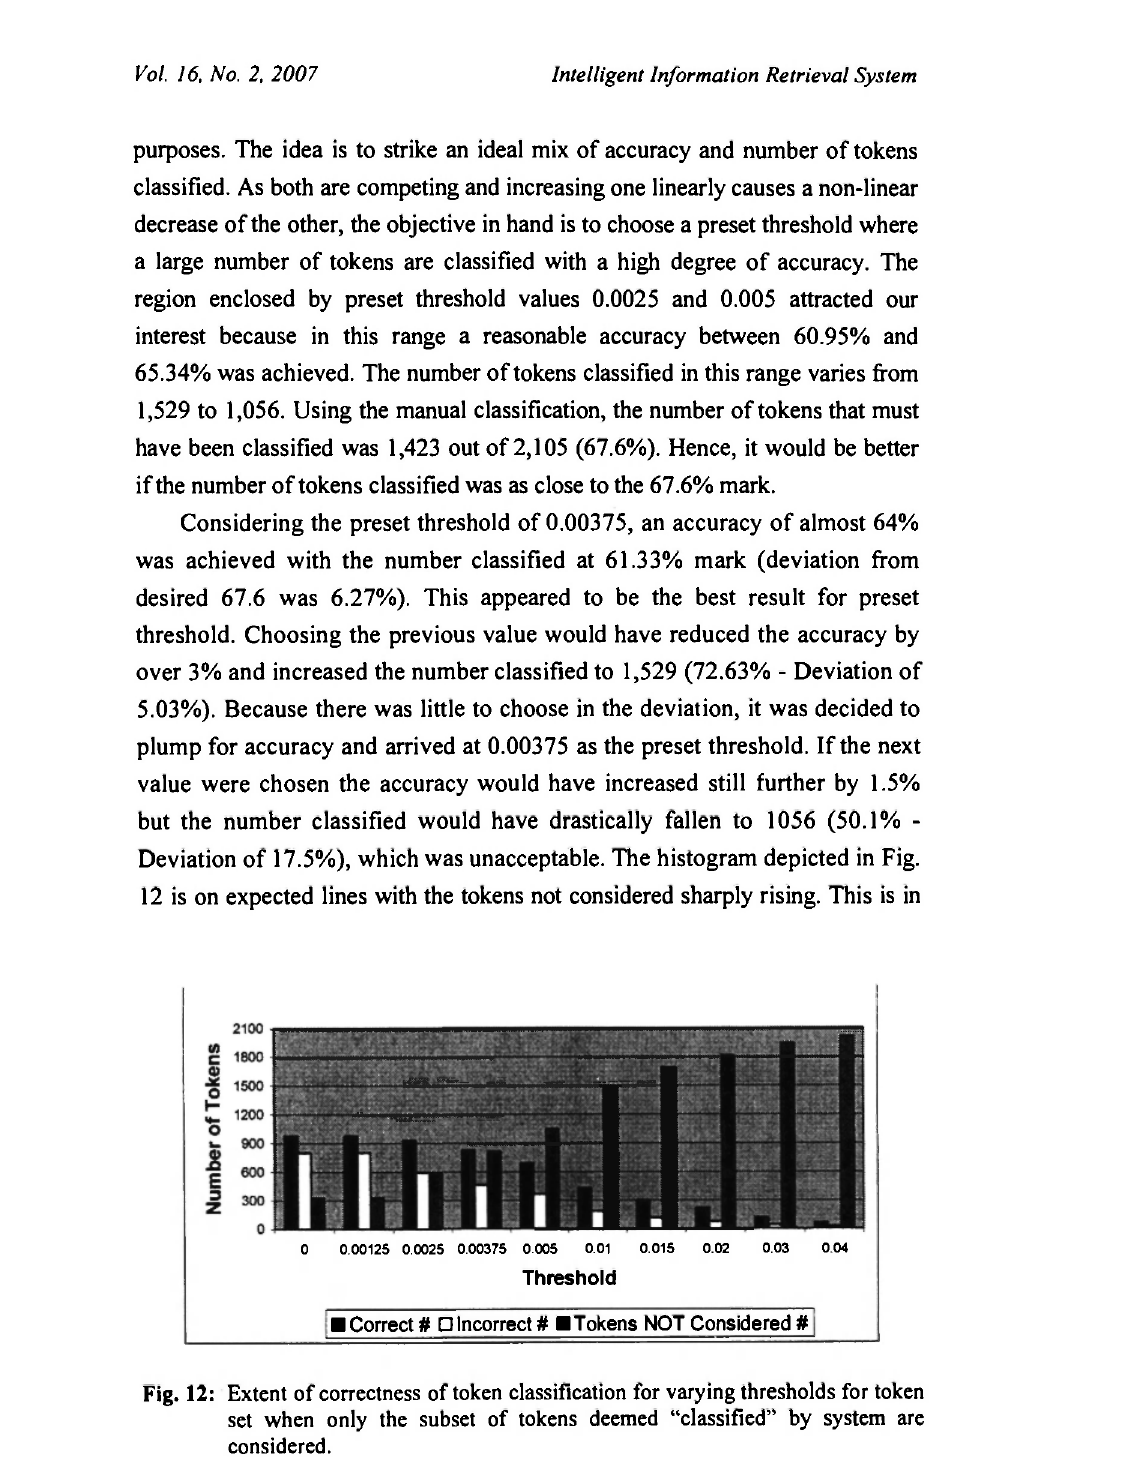
Fig. 12: Extent of correctness of token classification for varying thresholds for token set when only the subset of tokens deemed "classified" by system are